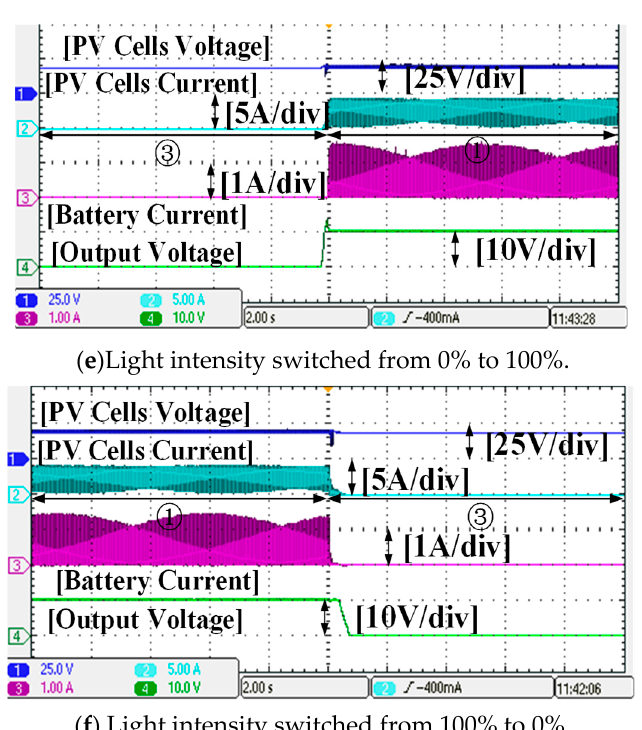
Figure 17. Maximum power point tracking experimental waveform.